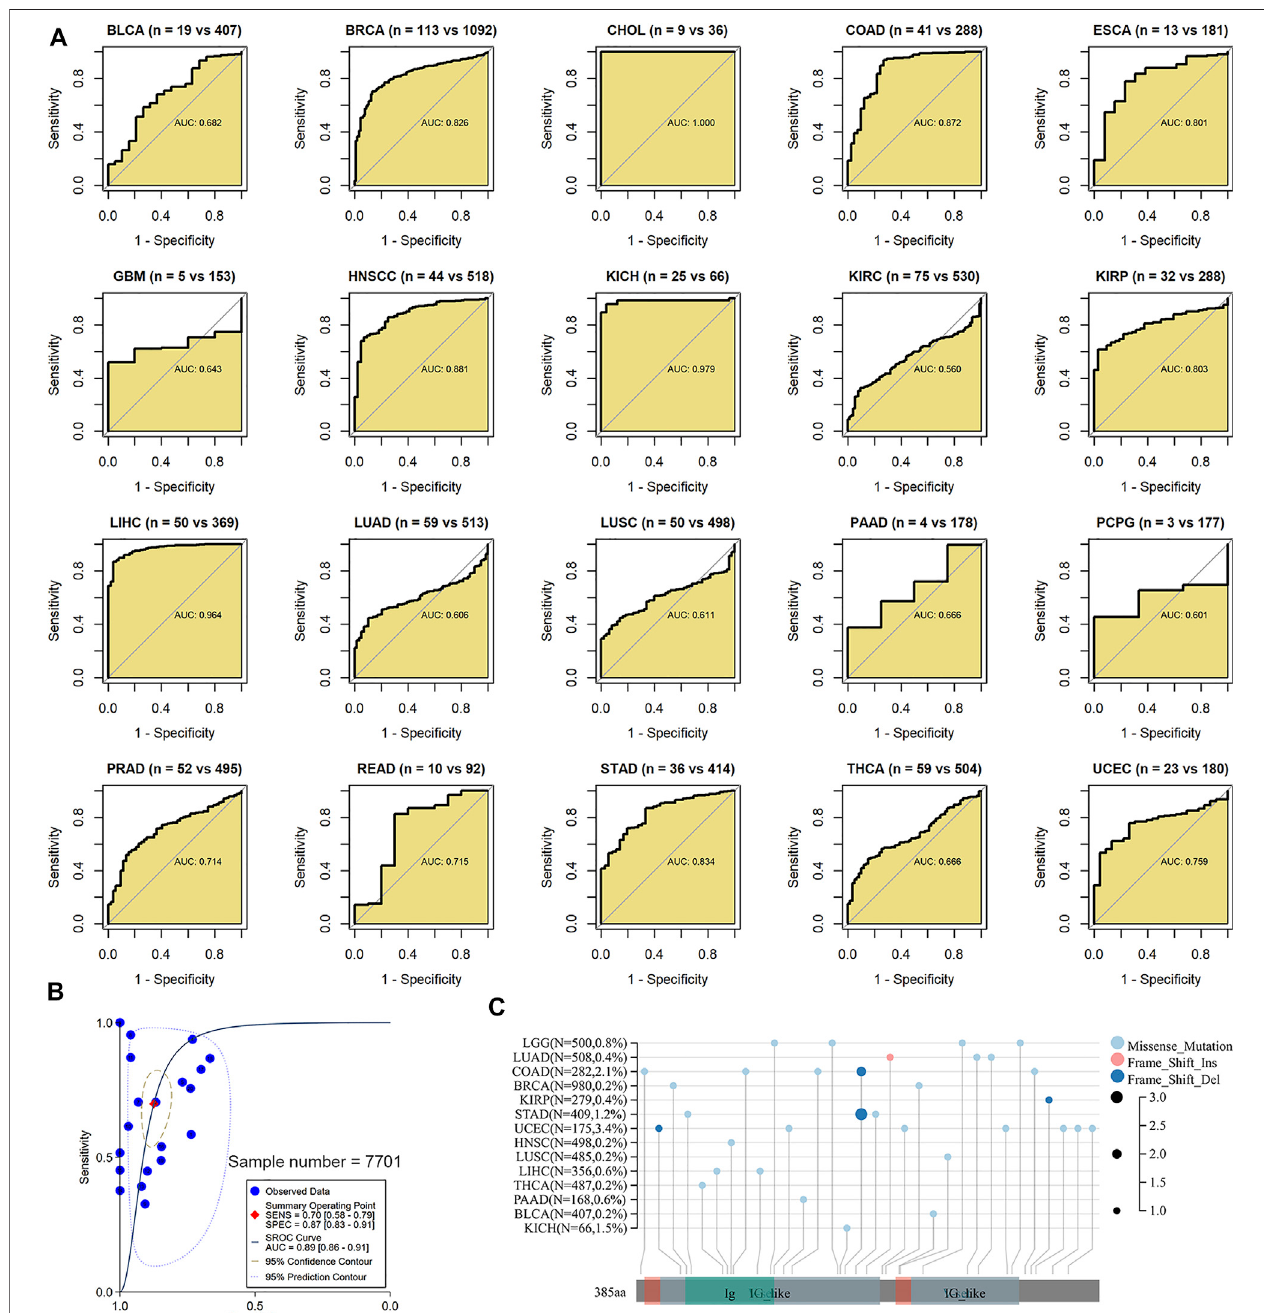
FIGURE6| AbilityofBSGexpressiontodistinguishthesecancertissuesfromtheirnormaltissuesandalandscapeofBSGmutationsinpan-cancer. (A) Inreceiver operating characteristic curves, BSG demonstrated pronounced effects in identifying cancer tissues from their control counterparts based on the area under the curve (AUC). The two values (e.g., “ n = 19 vs. 407 ” for BLCA) in parentheses represent the numbers of controls and cancers, respectively. (B) In the summary receiver operating characteristic curve, the BSG expression can accurately identify the 20 types of cancers samples from their controls. (C) Missense mutation is the most common alternation for BSG in pan-cancer;the panel plot was obtained from sangerBox 3.0; Del, deletion; Ins, insertion. BLCA, bladder cancer; BRCA,invasive breast carcinoma; CHOL, cholangiocarcinoma; COAD, colon adenocarcinoma; ESCA, esophageal carcinoma; GBM, glioblastoma multiforme; HNSCC, head and neck squamous cell carcinoma; KICH, kidney chromophobe; KIRC, kidney renal clear cell carcinoma; KIRP, kidney renal papillary cell carcinoma; LIHC, liver hepatocellular carcinoma; LUAD, lung adenocarcinoma; LUSC, lung squamous cell carcinoma; PAAD, pancreatic adenocarcinoma; PCPG, pheochromocytoma and paraganglioma; PRAD, prostate adenocarcinoma; READ, rectum adenocarcinoma; STAD, stomach adenocarcinoma; THCA, thyroid carcinoma; UCEC, uterine corpus endometrial carcinoma; LGG, brain lower grade glioma.